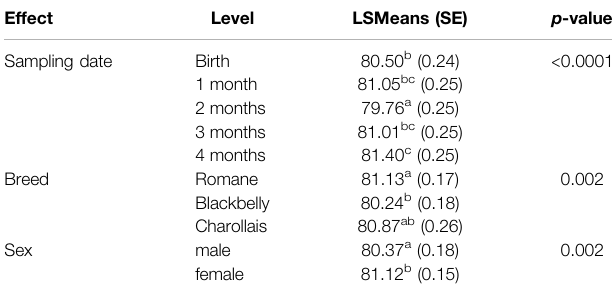
TABLE 1 | Effects of sampling date, breed, and sex on blood GDMR.